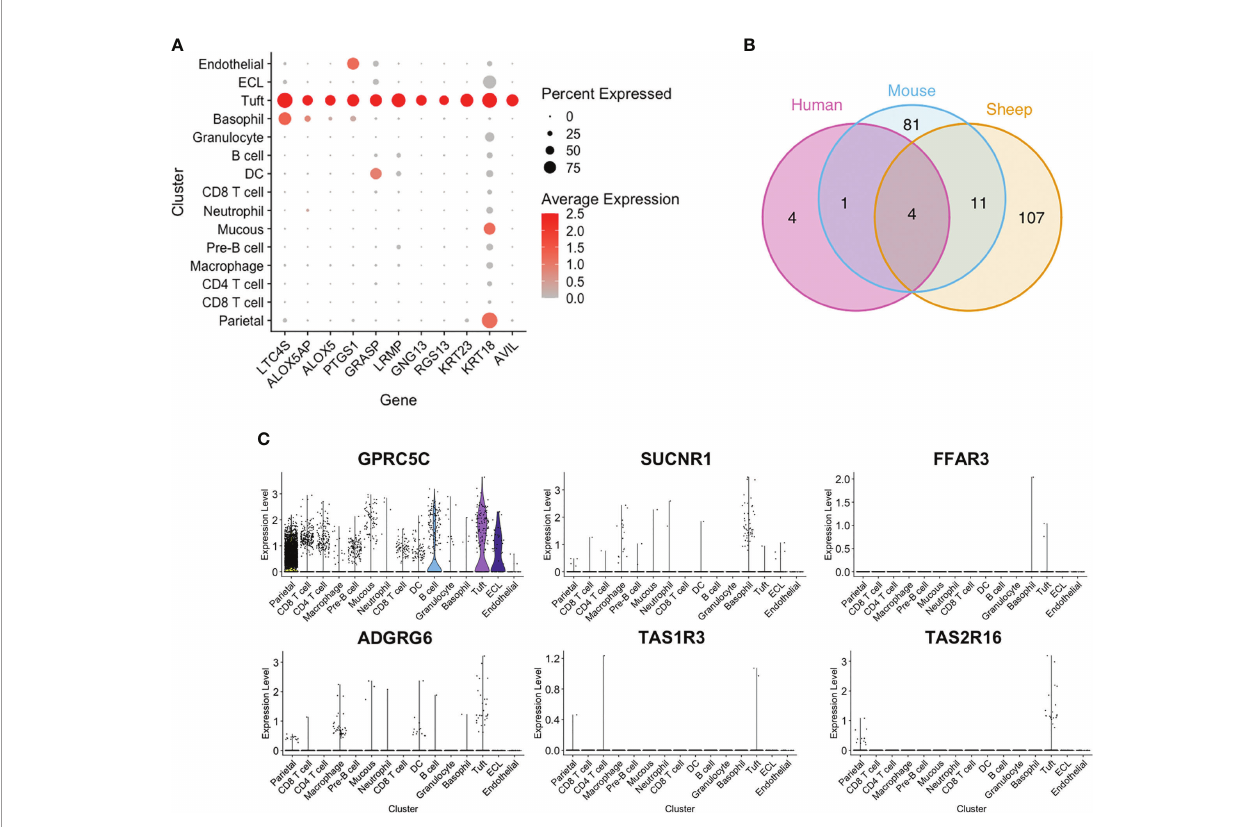
FIGURE 5 | Conservation and divergence of genes associated with tuft cell function. (A) Dot plot showing log-normalised expression of selected tuft cell genes across clusters. (B) Venn diagram of ovine abomasal and mouse SI tuft cell enriched genes (Log2 fold change >0.5; FDR < 0.05), and genes conserved in human tuft cells from different tissues. Ovine, human and mouse data from this study, and (9, 32), respectively. The four genes conserved in all three species are AVIL, ALOX, ALOX5AP, PTGS1 ; the 11 genes conserved in sheep and mouse are GNG13, LRMP, LTC4S, RGS13, KRT18, KRT23, BMX, SPIB, SH2D7, TSPAN6, TMEM45B . (C) Violin plot of log-normalised expression of GPCRs across all